Question: Briefly state, in one sentence, what is plotted here.
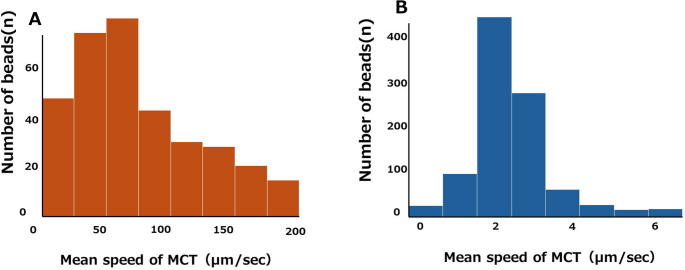
Answer: MCT velocity in both central and peripheral airways ( n =5). MCT velocity is measured by tracking the movement of 1-μm fluorescent beads using a high-speed camera attached to a fluorescence microscope. The histograms show the distribution of MCT velocity measured under identical experimental conditions in the central and peripheral airways. MCT velocity in the central airways is several tens of times higher than that in the peripheral airways